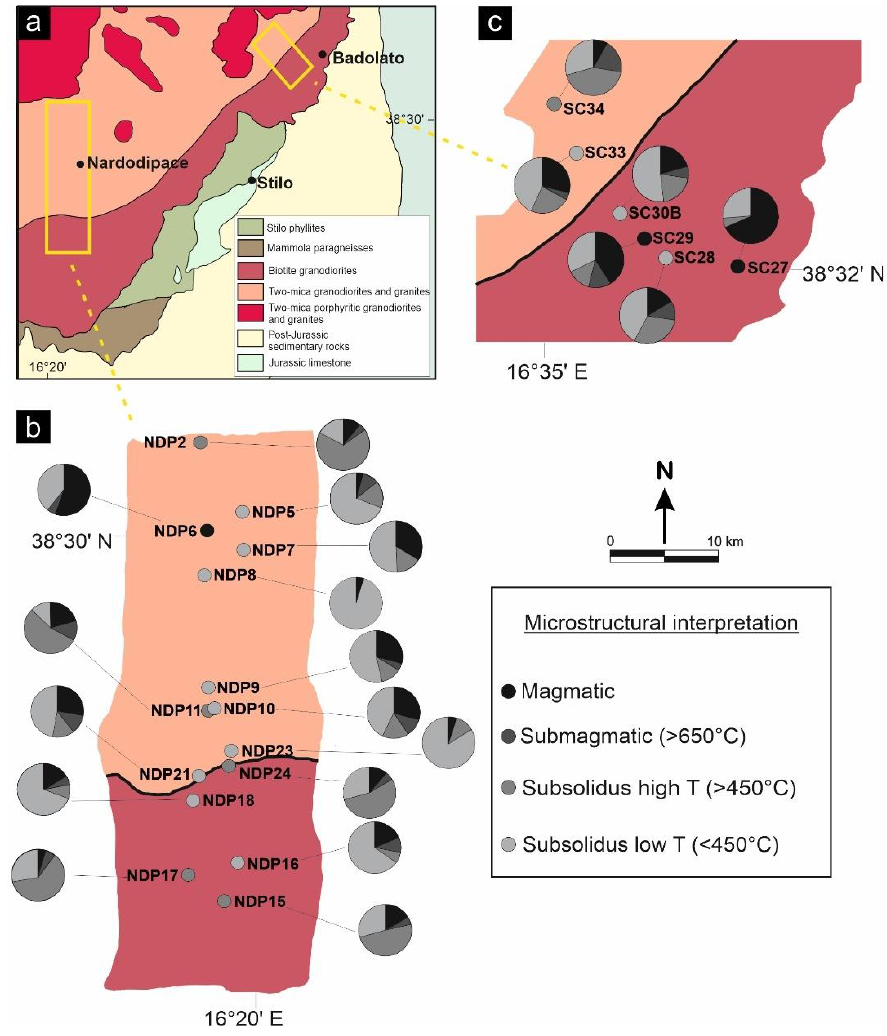
Figure 9. Microstructural interpretation of the samples in the study area ( a ) along the geological transects belonging to the Nardodipace ( b ) and Badolato ( c ) transects. Relative proportions of the different types of microstructures estimated in each studied sample are illustrated through pie charts.